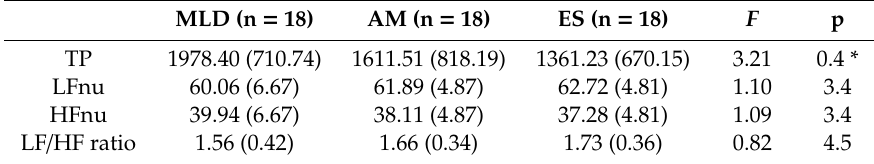
Table 4. ANOVA analyses of autonomic nervous system measures (n =